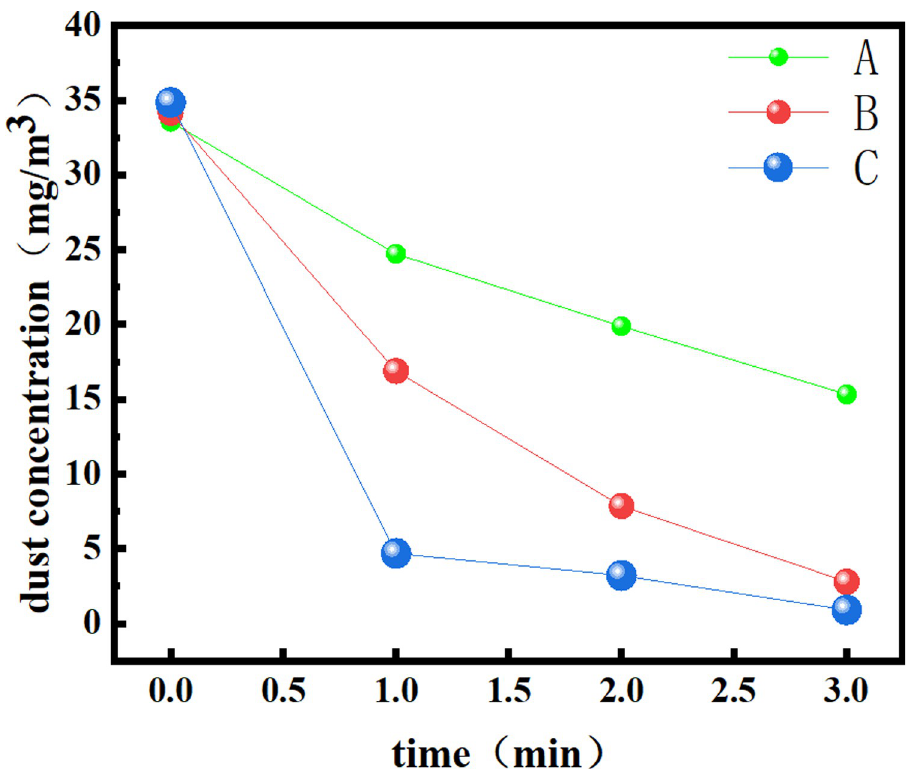
Fig 14. Change in the exhaled dust concentration measured for each of the three dust removal